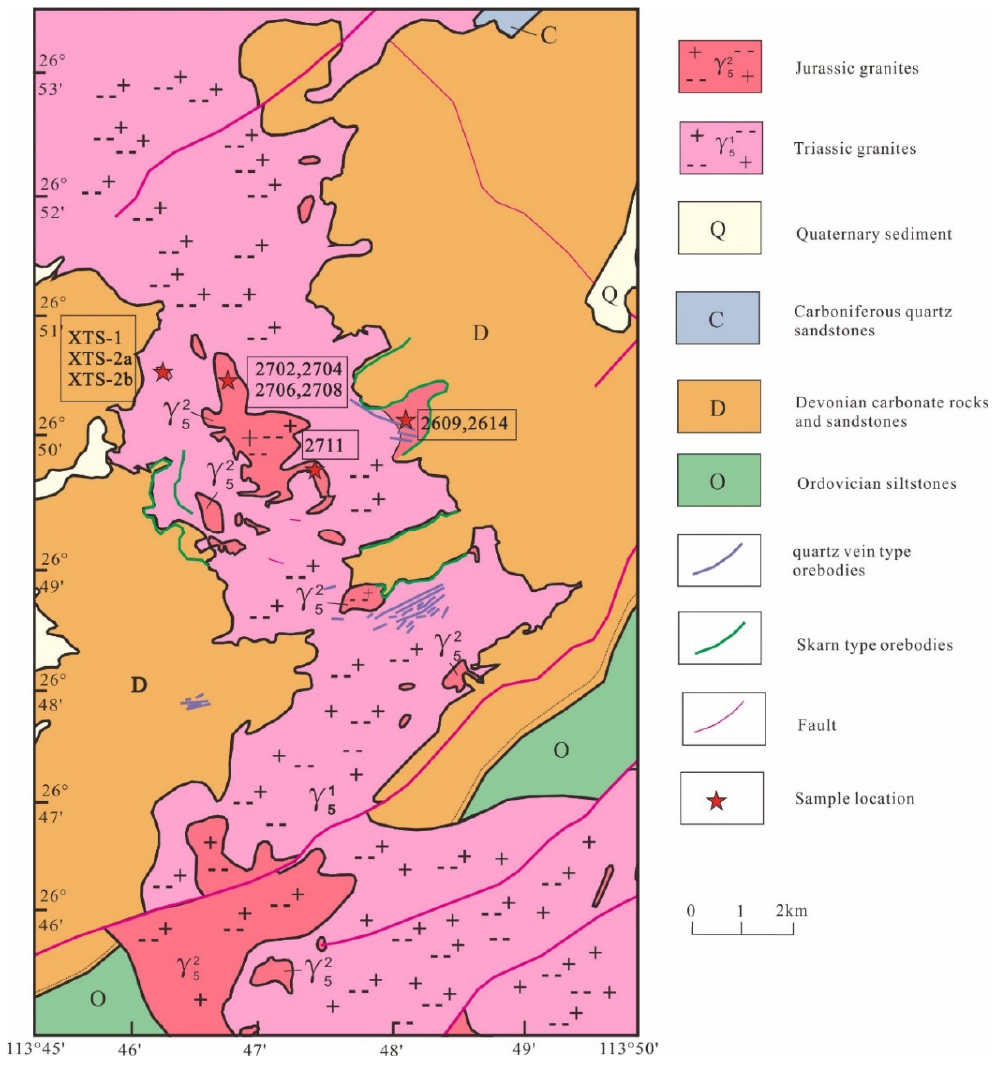
Figure 2. Geological sketch map of the Xitian ore field (modified after [32]).